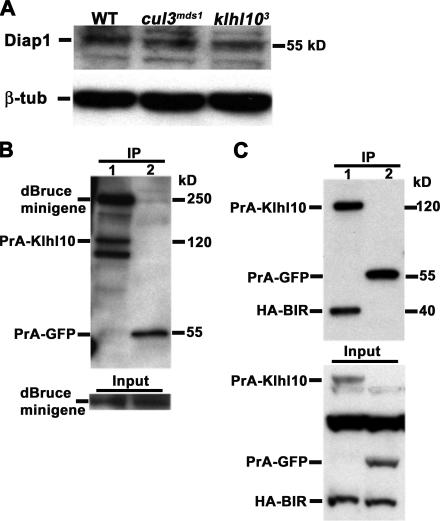
Diap1 Levels Are Not Affected in the Absence of the Functional Cul3-Roc1b-Klhl10 Complex, but dBruce Can Interact with the Substrate Recruitment Protein Klhl10 in S2 Cells(A) Diap1 protein levels were not affected in cul3mds1 and klhl103 mutant testes, as assessed by Western blotting of protein extracts from dissected testes. Therefore, Diap1 does not appear to be a major target for the Cul3-based E3-ligase complex. β-tubulin protein levels served as loading control.(B andC) Co-IP experiment in S2 cells indicate that Klhl10 can bind to the BIR domain of dBruce. The immunoprecipitate (IP) is shown at the top, and pre-incubation of whole lysates are shown at the bottom (Input). Cell lysates were incubated with IgG beads which bind to Protein A (PrA). For Western blotting of IPs, (B) anti-dBruce antibody or (C) anti-HA antibody were used.(B) Cells were co-transfected with a dbruce “mini gene” (consisting of the first N-terminal 1,622 amino acids, including the BIR domain, and the last C-terminal 446 amino acids that contain the UBC domain) and (lane 1) PrA-klhl10 or (lane 2) PrA-GFP (see Materials and Methods for details).(C) Cells were co-transfected with HA-tagged dBruce-BIR peptide containing the first N-terminal 387 amino acids of dBruce that includes the BIR domain region (amino acids 251–321). This motif is sufficient to bind to Klhl10 in S2 cells (see Materials and Methods for details).